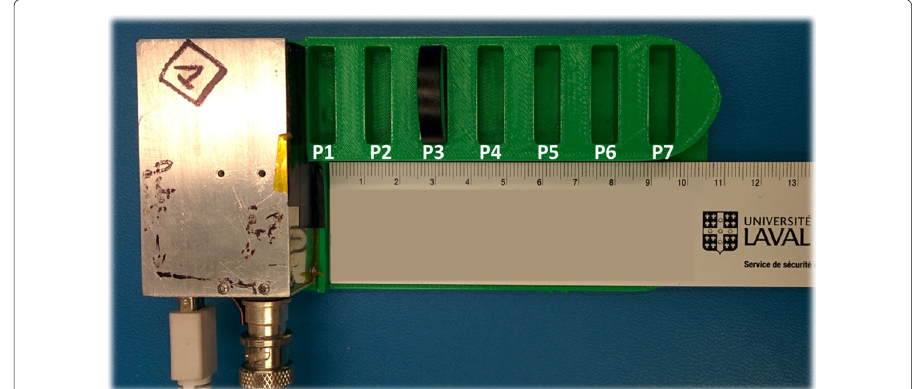
Fig. 6 Positioning template for the 137 Cs